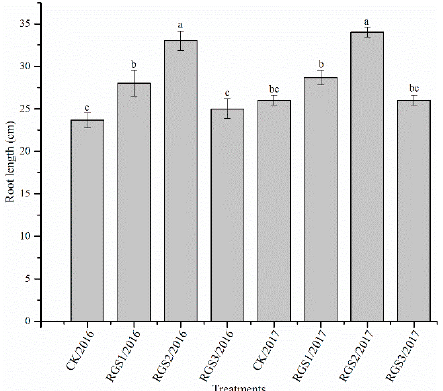
Figure 2. Effect of amendment with raw garlic stalk on root length of eggplant. The error bars represent standard error of the means ( n = 3). The error bars represent standard of the means. Different letters between treatments at different sampling stages show significant difference at p < 0.05 level (ANOVA and LSD).